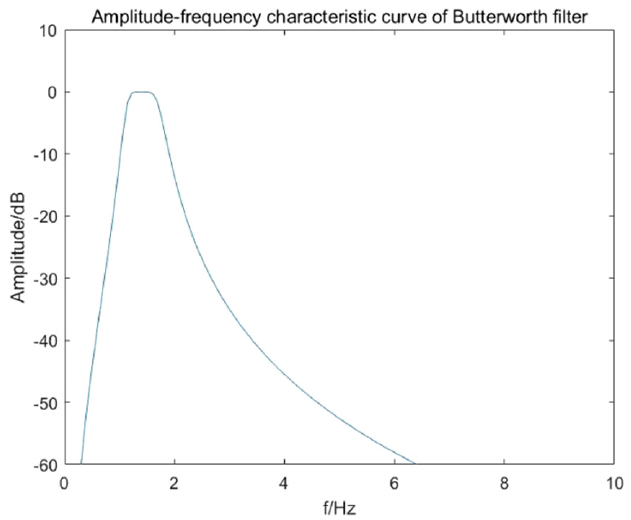
Figure 22. Amplitude–frequency characteristic of Butterworth filter for heartbeat signal extraction. The restoration results and normalized spectrum of the original signal and each step’s processed signal are shown in Figure 23c,d.